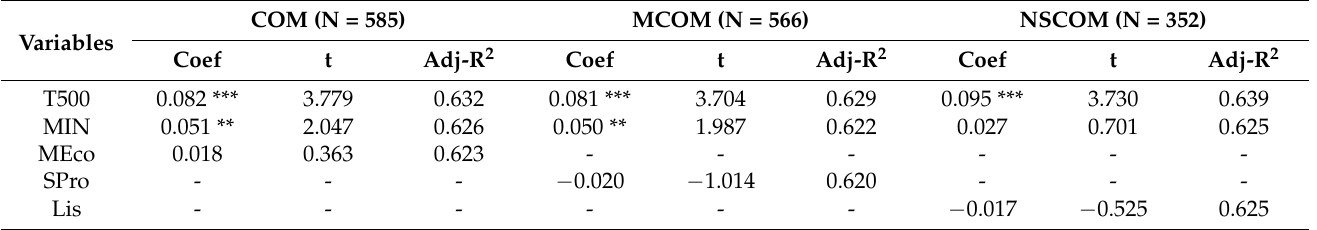
Table 4. Linear regression results of the developer